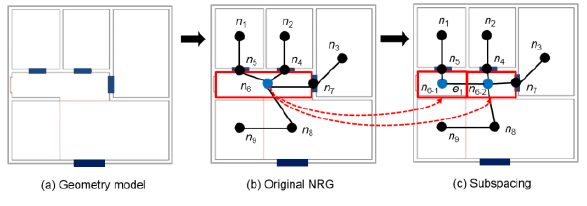
Figure2 Example of subspacing